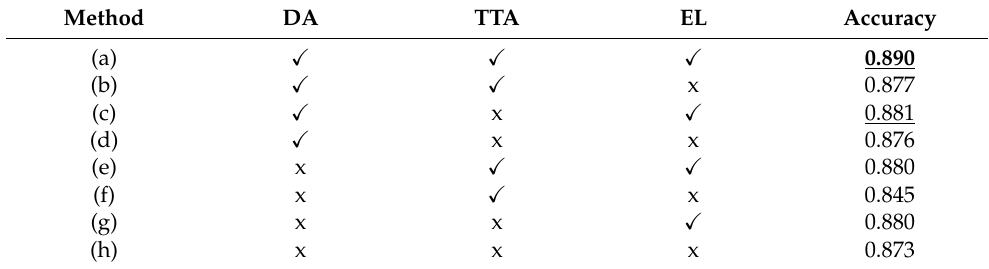
Table 2. Accuracy of the eight methods used in the experiment. DA, TTA, and EL are denoted by (cid:88) for those applied and x for those not applied. The highest accuracy is underlined and bolded, and the second highest is